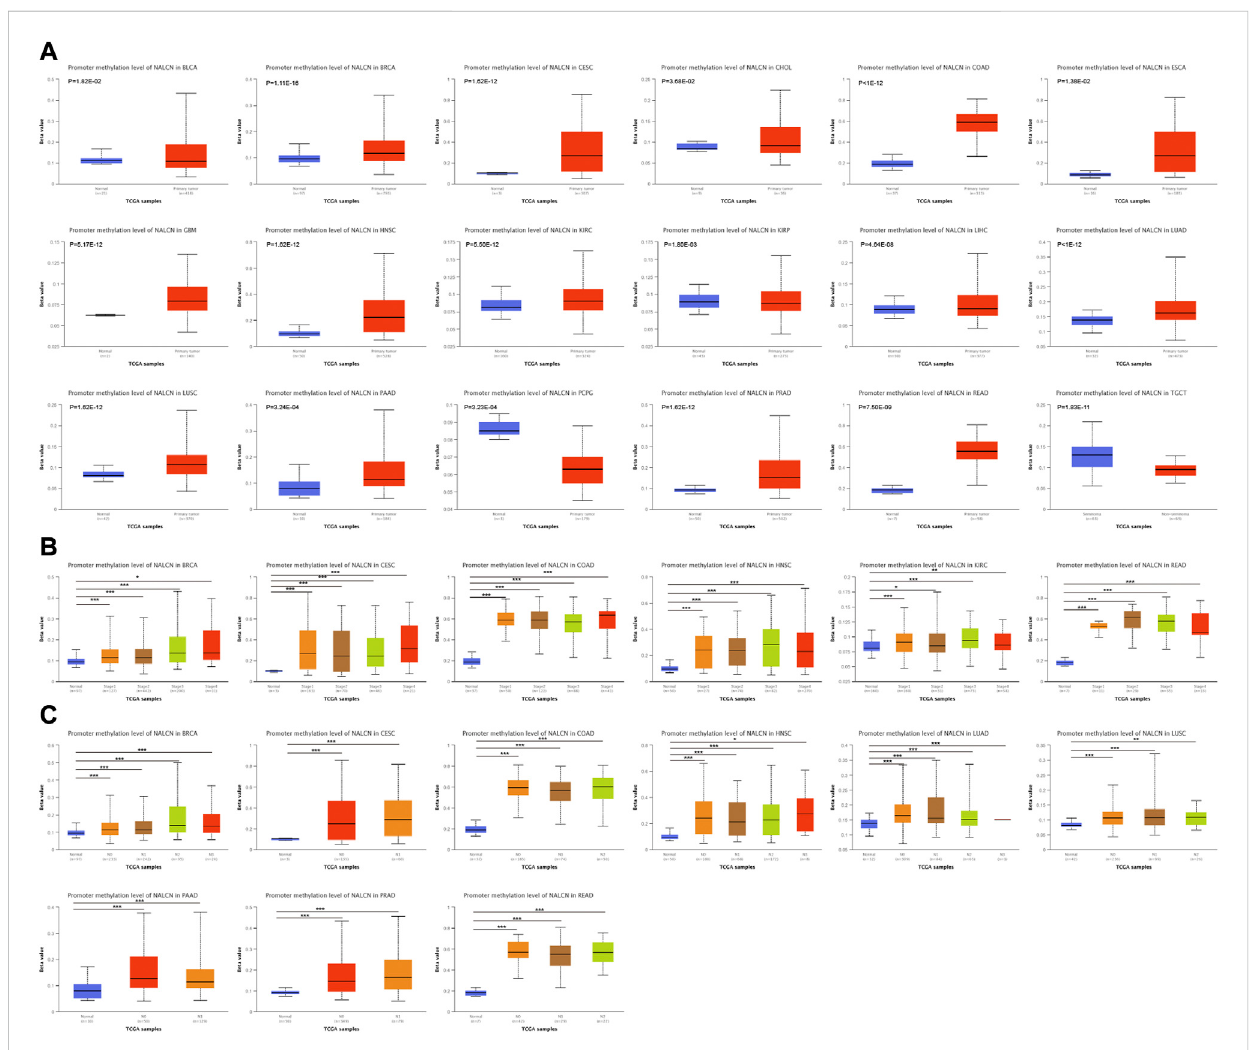
FIGURE 9 The promoter methylation level of NALCN in cancers. (A) The promoter methylation level of NALCN between tumor and normal samples. (B) The promoter methylation level of NALCN between tumor with different stage and normal samples. (C) The promoter methylation level of NALCN between tumor with different lymph node metastasis status and normal samples. * p < 0.05, ** p < 0.01, *** p <